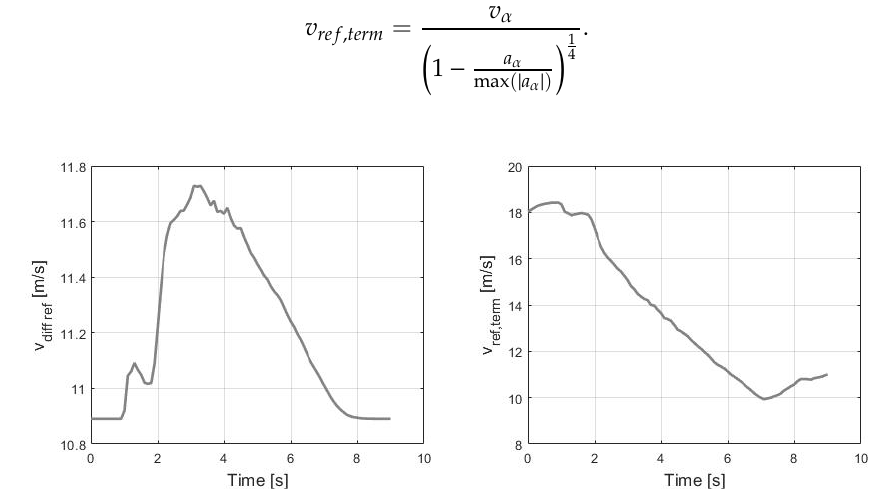
Figure 3. Deceleration profile in general car-following.